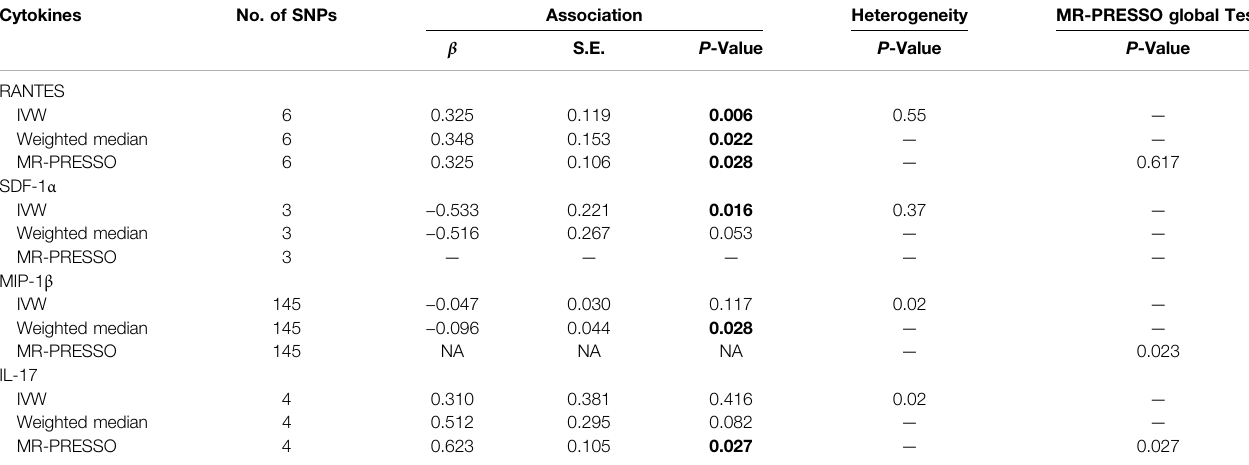
TABLE 1 | MR analysis of the causal relationship between RANTES, SDF-1 α , MIP-1 β and IL-17 levels and psoriasis vulgaris. Cytokines